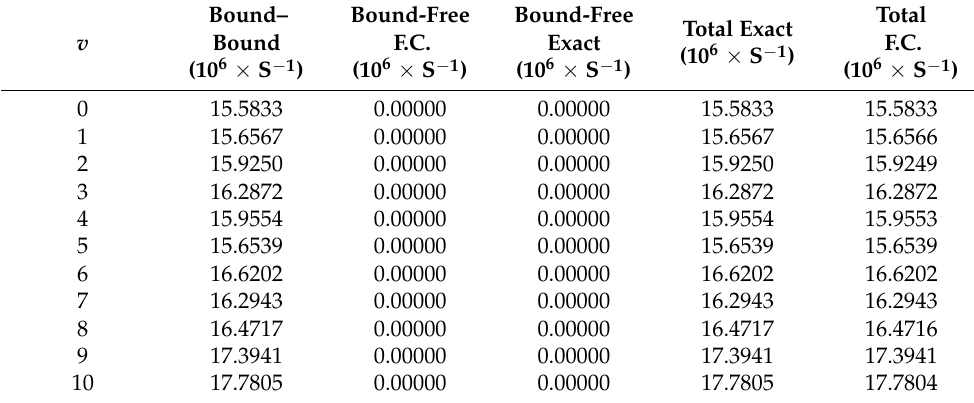
Table 4. Radiative lifetime associated with the C → X emission of the ion (SrK) +